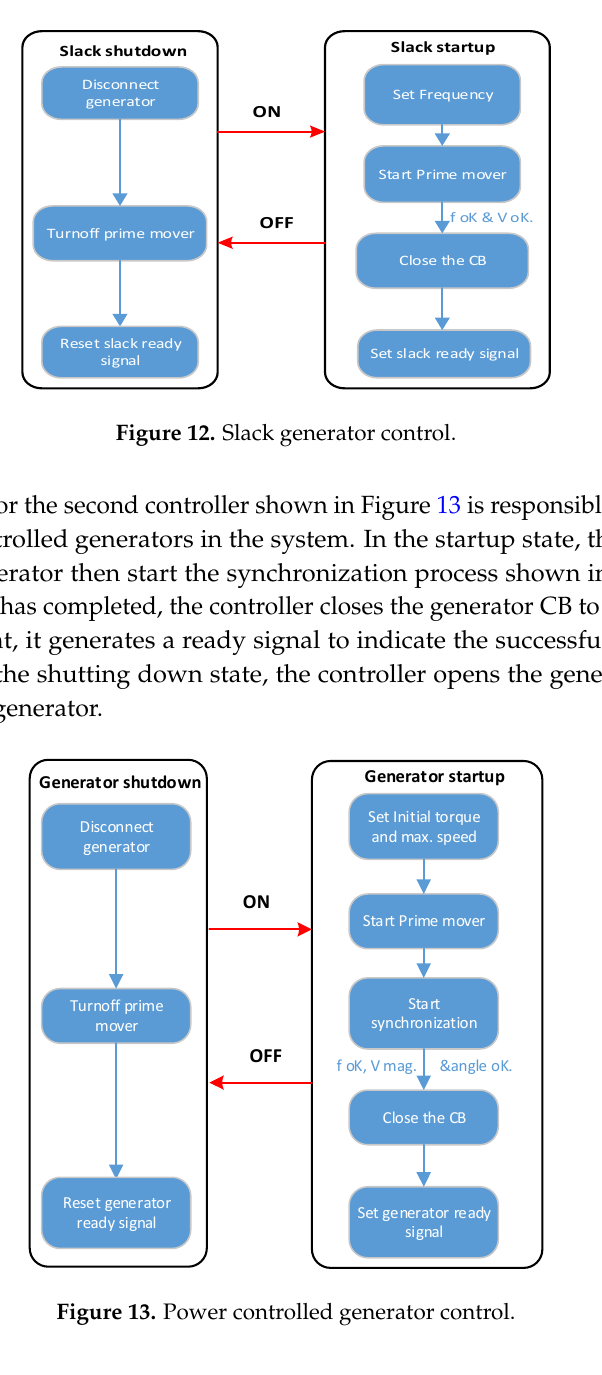
Figure 14. Synchronization controller. The high level controller is responsible for coordinating the operation of the low level generator startup controllers and configuring the testbed network topology by connecting necessary transmission lines, busbars, and loads. As shown in Figure 15, the main controller consists of two main states: namely, startup and shutdown. In the startup state, the controller calls the generator start up algorithms in the required order and monitors the generator status. Then, it connects the CBs to configure the testbed topology and connect the loads. Once all the generators are running and the topology configuration is done, it generates a ready signal for the entire testbed. This signal can be used to enable starting up a certain experimentation procedure. In the shutdown state, the controller shuts down the generators in the correct order by shutting down the power controlled generators one ‐ by ‐ one while disconnecting any connected loads to avoid overloading the remaining generators. Finally, after shutting down all the power controlled generators, the slack generator is disconnected and all circuit statuses are reset to an open state.